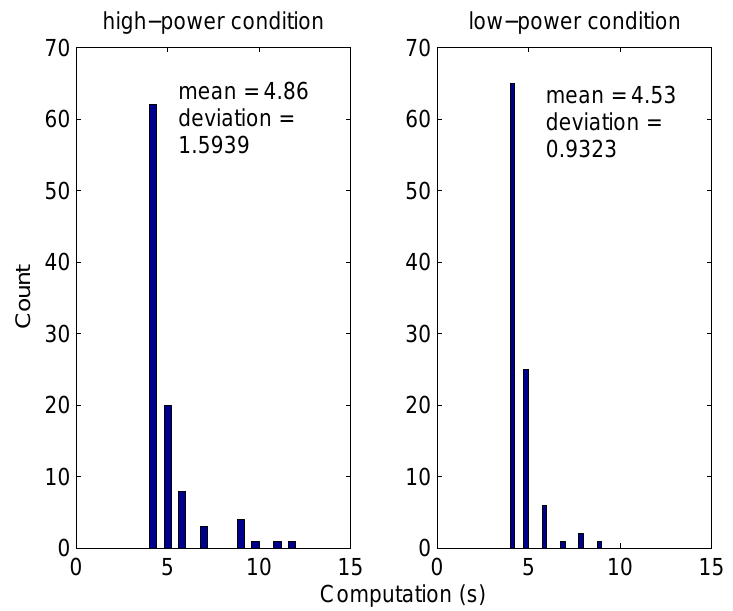
Figure 24. Histogram of the computation time under the energy-efficiency-oriented policy for ( left ) high and ( right ) low power storage